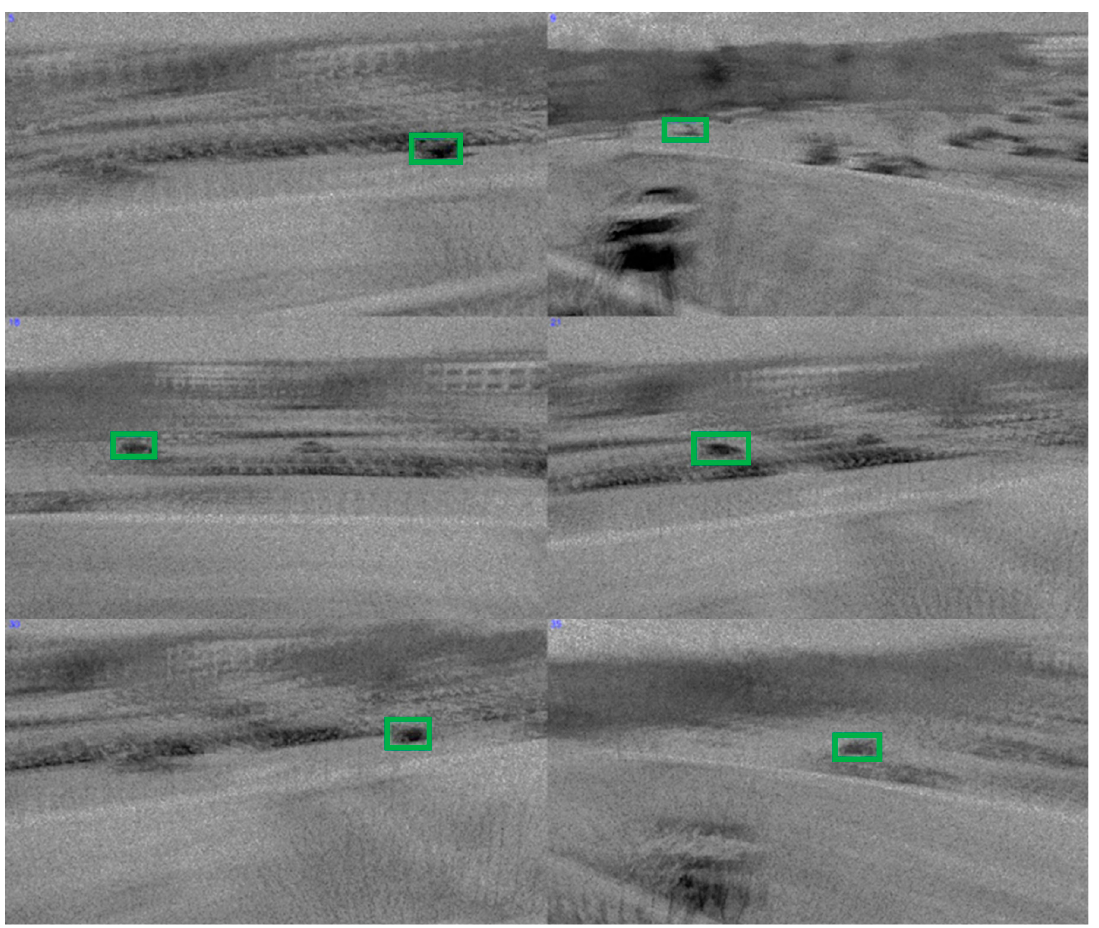
Figure A4. IMG430 50 percent missing tiled image results. Bounding box detections outlined in green.